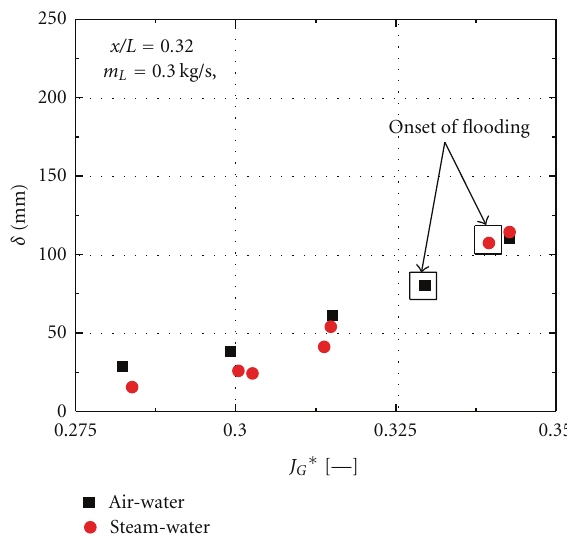
Figure 13: E ff ect of physical properties on the water